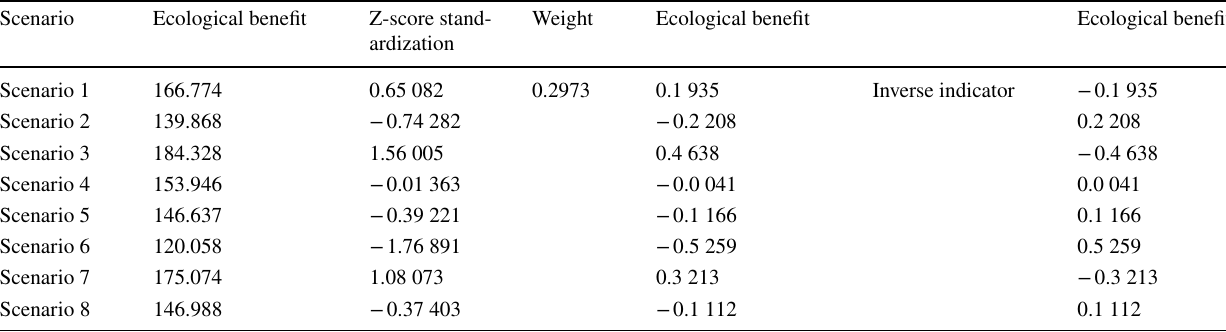
Table 4 Ecological benefit value of each scenario in 2035